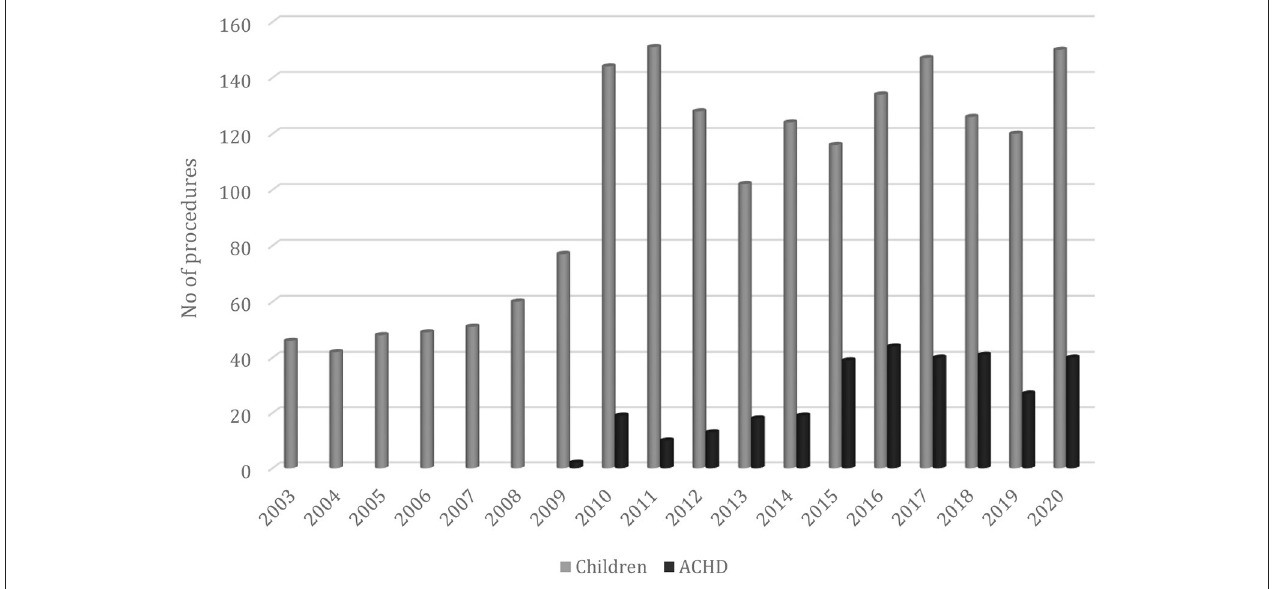
FIGURE 1 | Number of procedures per year in Croatia (2003–2020).